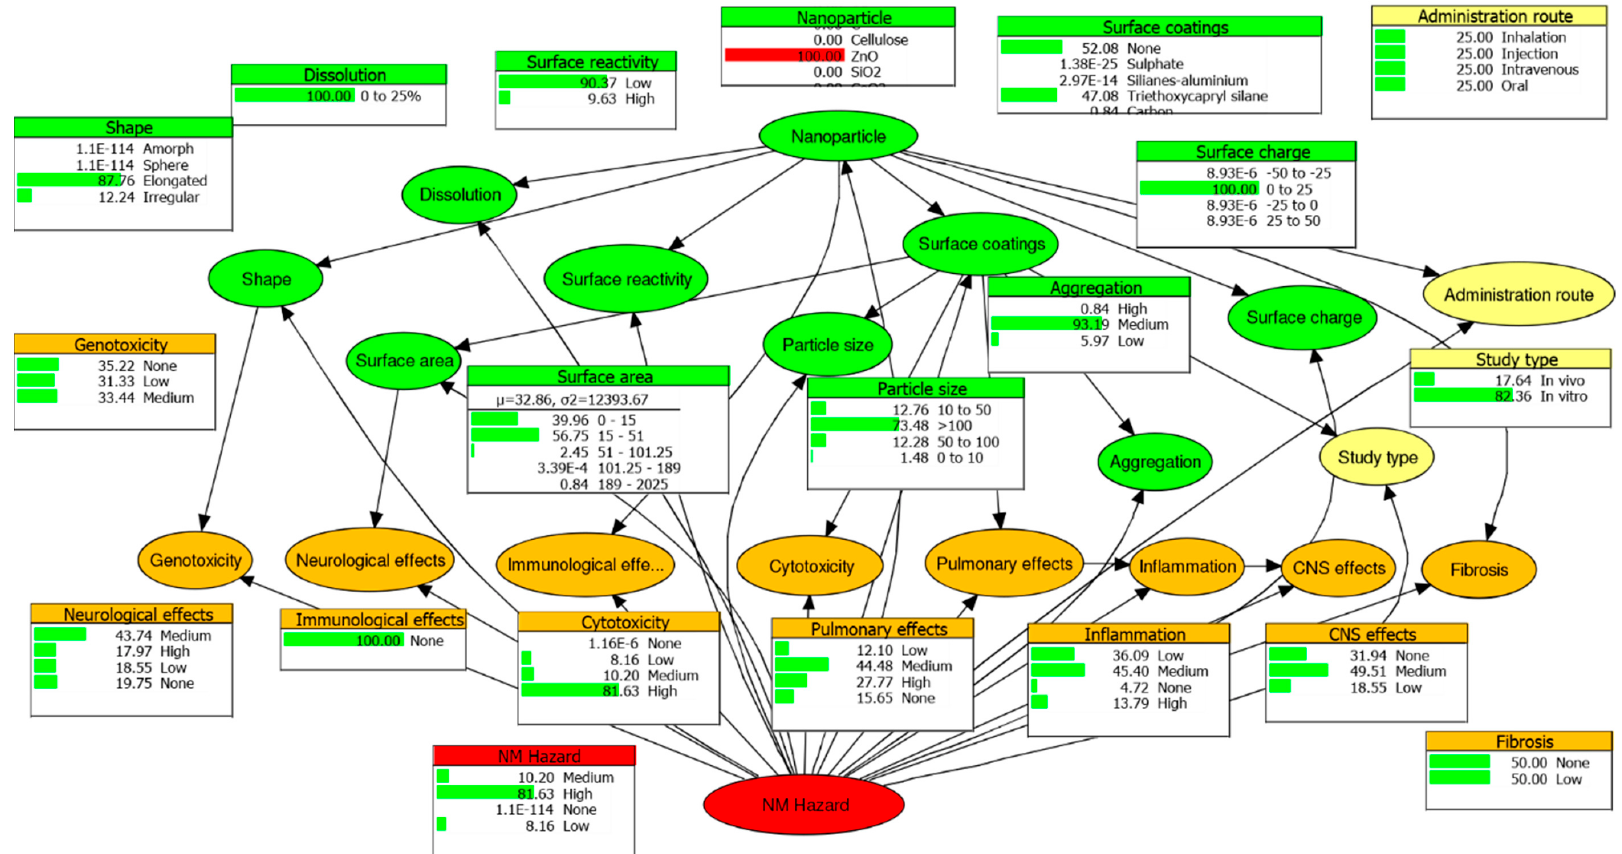
Figure A2. Graphical structure and parameterization of the BN with ZnO input as evidence. Ellipses represent nodes and directed links signify the conditional relationship between parent and child nodes. The accompanying bar charts denote the % state probabilities. The nodes are colour categorised into green for physicochemical properties, yellow for study type, orange for biological effects, and red for NM hazard potential. Adapted from Marvin et al. [9].